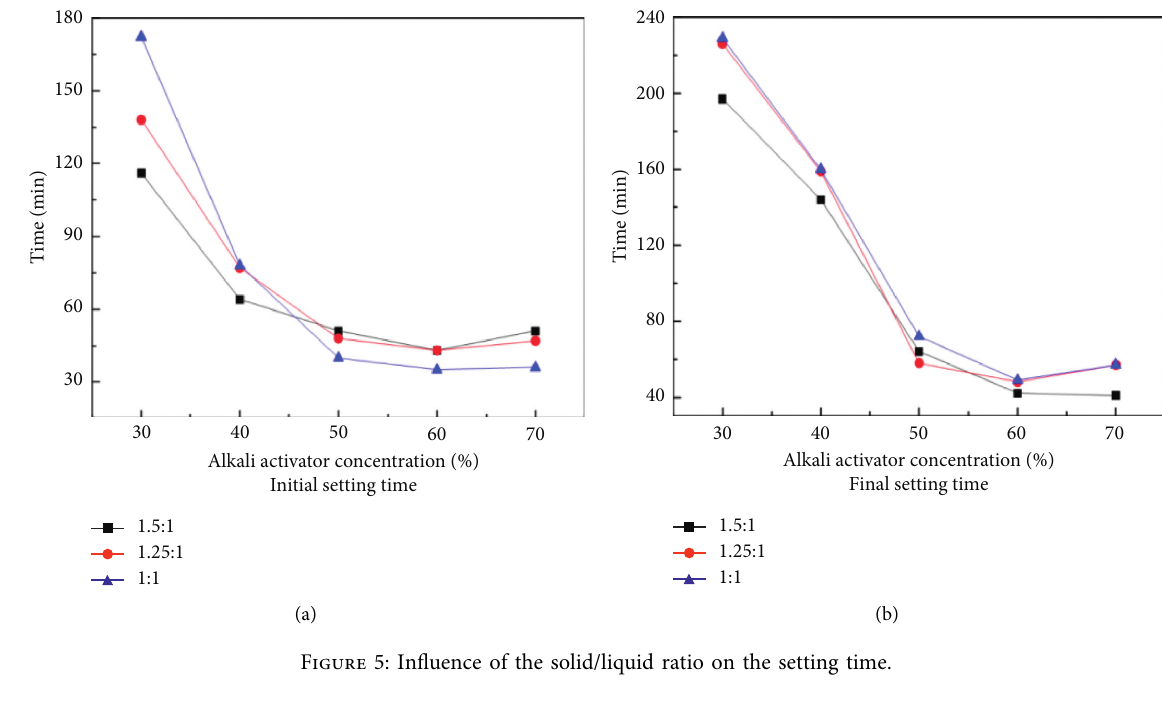
Figure 5: Influence of the solid/liquid ratio on the setting